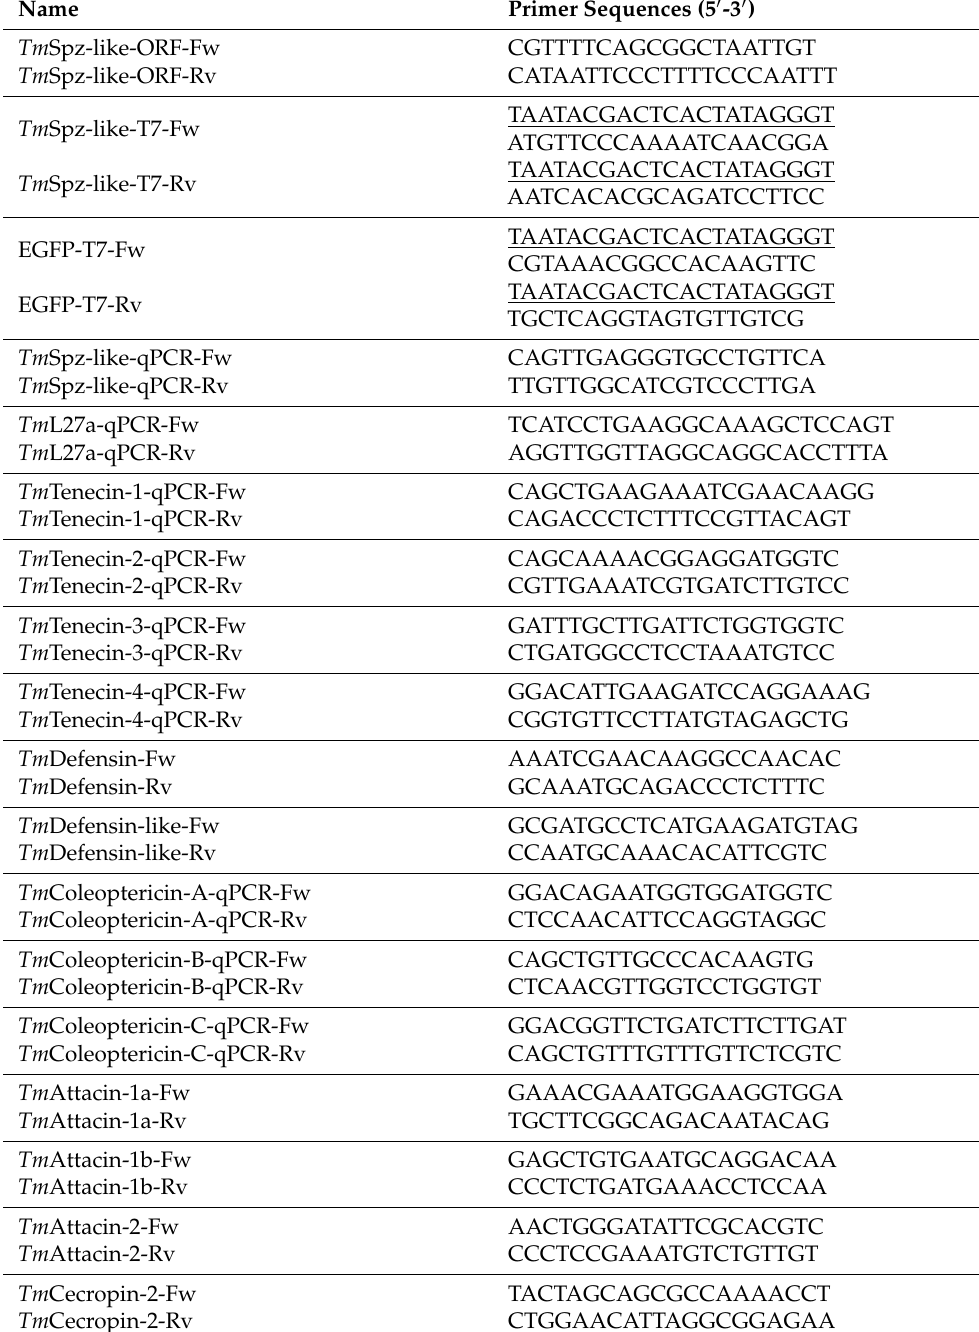
Table 1. Primers used in this